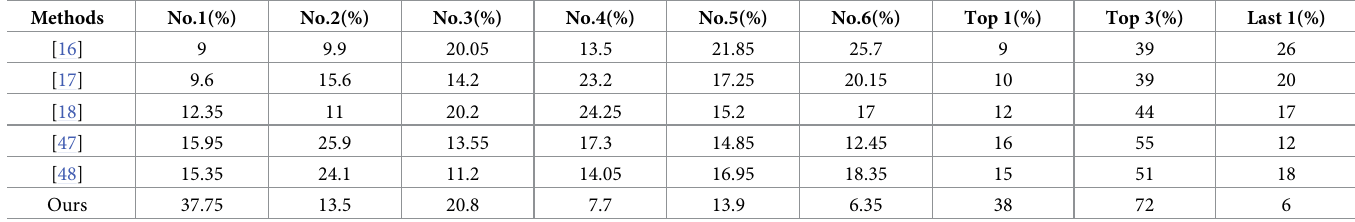
Table 9. The ranking analysis of coloring effects of six algorithms. Each set of images is still sorted in ascending order of 1 − 6. The formula satisfied here is as follows: Top 1 = No .1, Top 3 = No .1 + No .2 + No .3, Last 1 = No .6. It should be noted that the values of the last three columns in Table 9 are reserved only for the integer portion of the percentage.